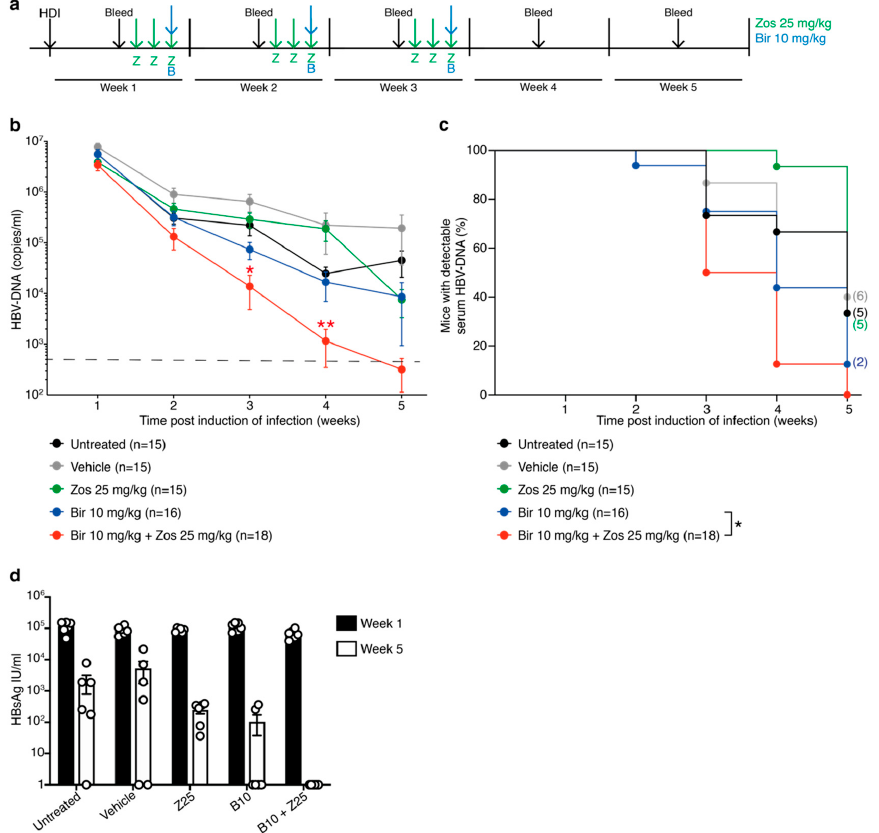
Figure 4. Zosuquidar enhances the efficacy of birinapant to eliminate HBV replication in C57BL/6 mice. ( a ) Long-term analysis treatment scheme of HBV-replicating C57BL/6 mice by HDI and preloaded with 25 mg/kg of zosuquidar (green arrows) for three days prior to ± 10 mg/kg of birinapant (blue arrows). Treatment strategy was repeated for three weeks. Animals were bled (black arrows) weekly prior to treatment and serum HBV-DNA levels analyzed. ( b ) Animals were treated as described in Figure 4a and serum HBV-DNA levels analyzed by qRT-PCR ( n = 15 − 19); pooled data of two independent experiments, dashed line indicates assay detection limit of 500 HBV-DNA copies/mL ( c ) Proportion of mice with detectable serum HBV-DNA ( n = 15 − 19, pooled data of two independent experiments). Number of mice with detectable HBV-DNA at week 5 is indicated in brackets on the graph; p values were calculated using a Log-rank (Mantel-Cox) test comparing birinapant and birinapant + zosuquidar. ( d ) HBV surface antigen (HBsAg) levels in serum of mice at weeks 1 and 5 post induction of infection. Graphs show mean ± SEM; * p < 0.05; ** p < 0.01 (Figure 4b, nonparametric Mann-Whitney test; Figure 4c, log-rank Mantel–Cox